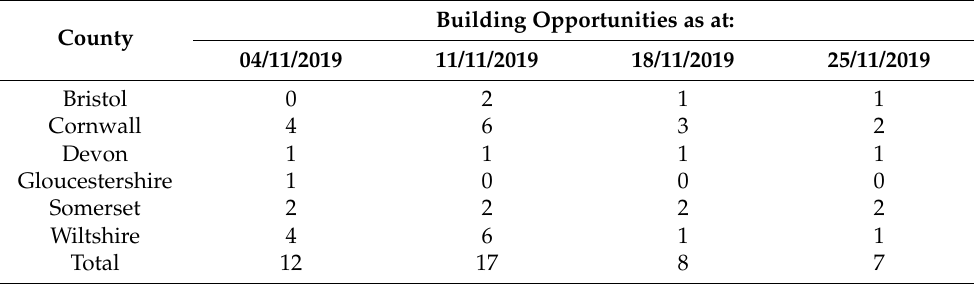
Table 13. LandBank Partnership building opportunities advertised in the study area during November